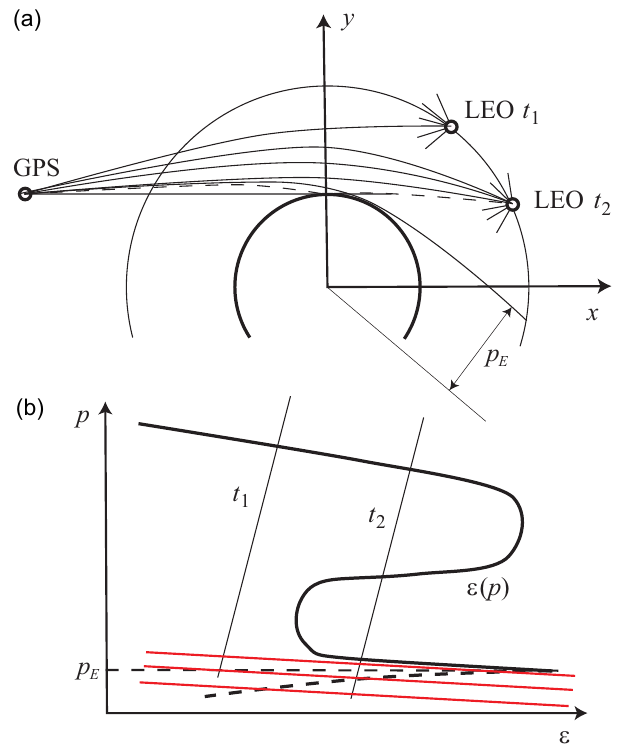
Figure 1. Reflection and multipath propagation geometry. (a) Up- per panel shows the radio occultation geometry. At moment of time t 1 , one ray is observed, at moment of time t 2 the receiver is in a mul- tipath area and observes 3 direct rays and one reflected ray. (b) Each moment of time corresponds to a line in the impact parameter – bending angle coordinate plane; the line indicating possible values of impact parameters and bending angles that can be observed by the receiver at this moment of time. p E is the impact parameter of the ray that touches the Earth’s surface. Reflected rays have impact parameters p < p E . The bending angle profile of reflected rays is shown as a dashed line. The lines shown in red represent the con- stant modified impact